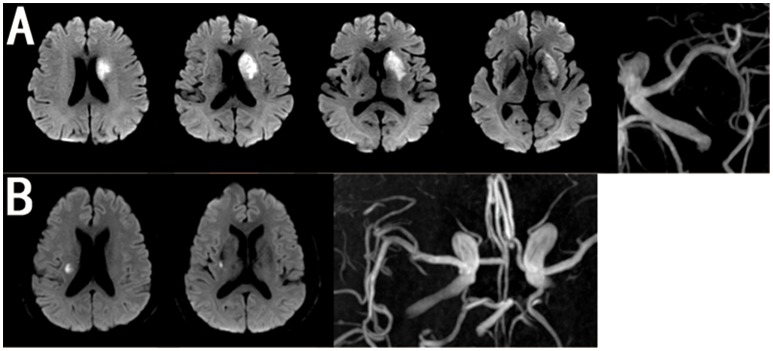
Representative MRI Images of BAD and LI in MCA. (A) BAD in anterior circulation with MRA showing none moderate or severe stenosis in ipsilateral MCA. (B) LI in anterior circulation with MRA showing none moderate or severe stenosis in ipsilateral MCA.